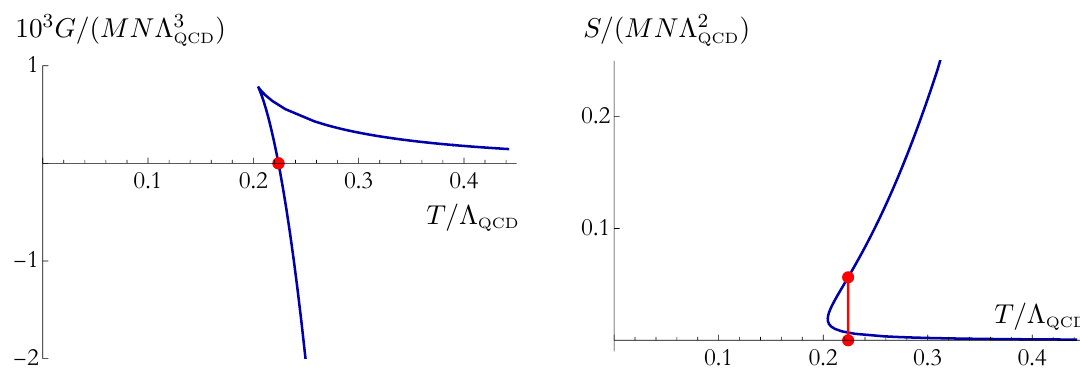
Figure 2. Left : difference in free energy between the deconfined plasma phase and the confining thermal state as a function of the temperature. When the curve is below the horizontal axis the plasma phase (black brane solutions) is dominant. There is a first order confining/deconfining phase transition when the curve crosses the axis. Right : corresponding curve for the entropy density as a function of temperature. At the phase transition, the entropy jumps from some finite value to zero, as depicted by the solid red line. We are plotting the quantities in units of the IR scale (2.2). with λ = g ‘ − 1 N the three-dimensional ’t Hooft coupling, with dimensions of energy. s s